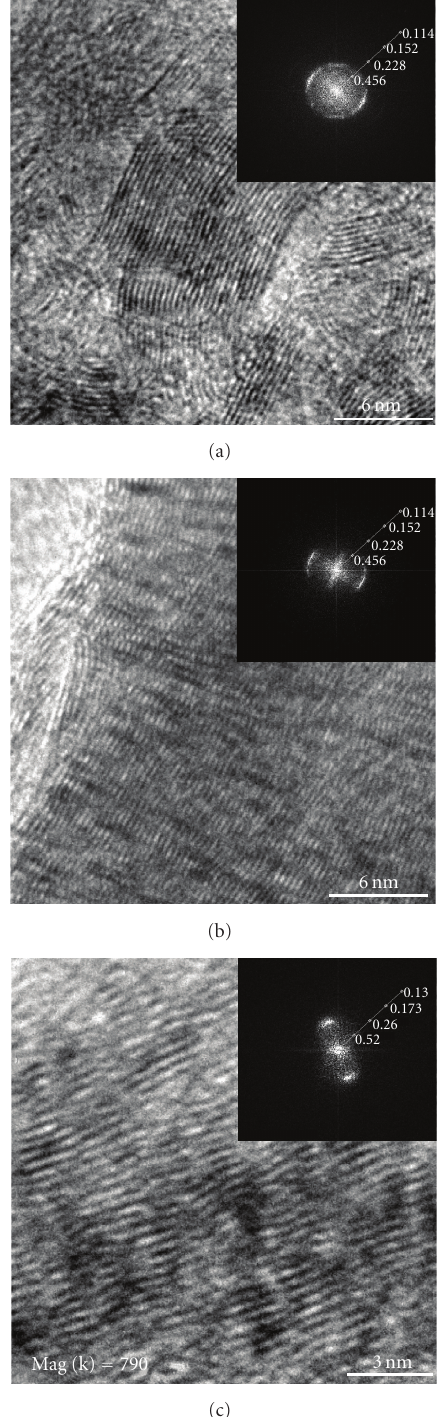
Figure 4: Representative SEM images of purified MWNTs for (a) 50% Co, (b) 25% Co + 25% Ni, and (c) 50% Ni on MgO support.